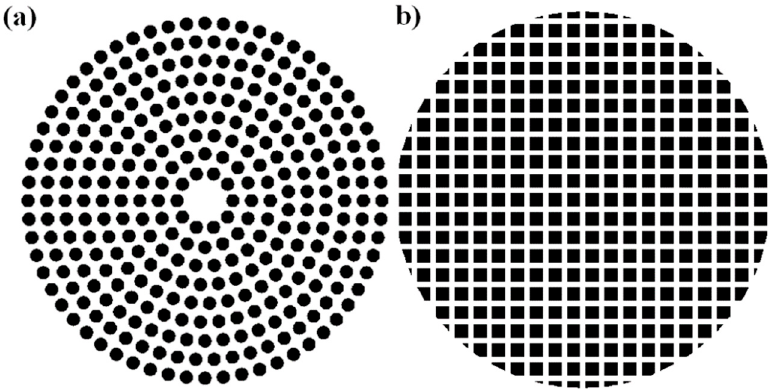
Figure 3. Geometric configuration of lapping with abrasive blocks in ( a ) concentric ring and ( b ) grid patterns.